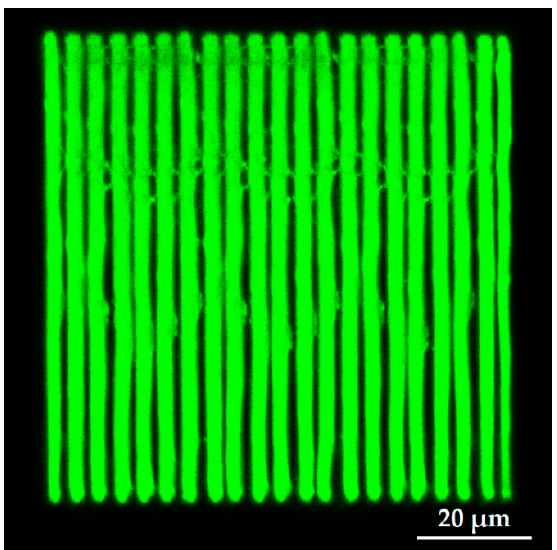
Figure 6. Isolated example of 3DLL-made square-grid membrane.